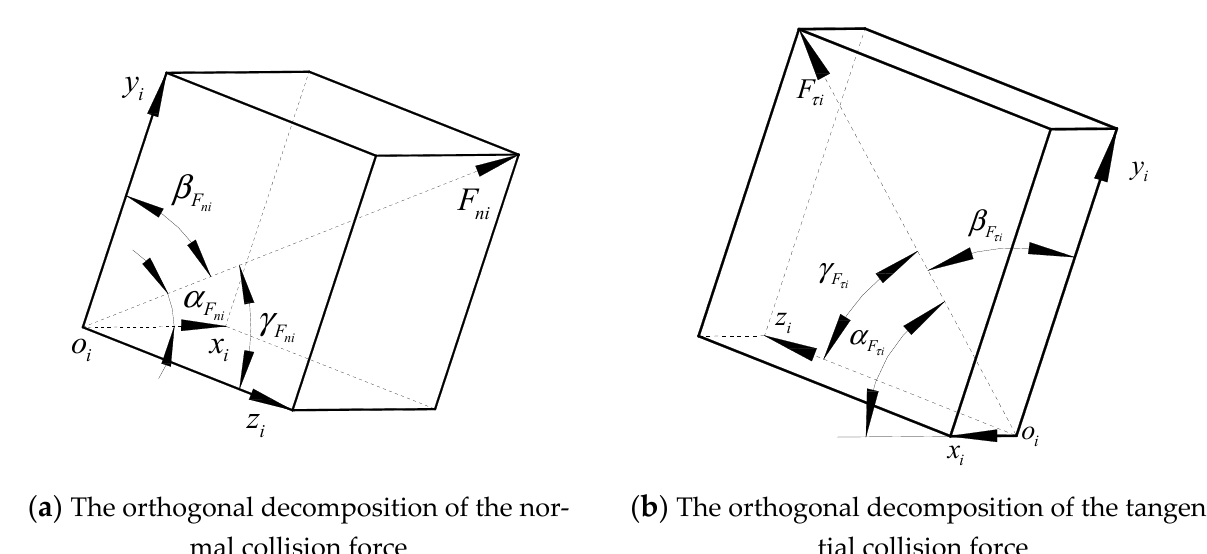
d δ  Figure 6. Relation diagram of relative sliding velocity and friction coefficients. 2.3.3. Vector Analysis of the Collision Force The harvesting collision force obtained by the above solution refers to the harvesting collision force under the row coordinate system. Since the research object of the machine